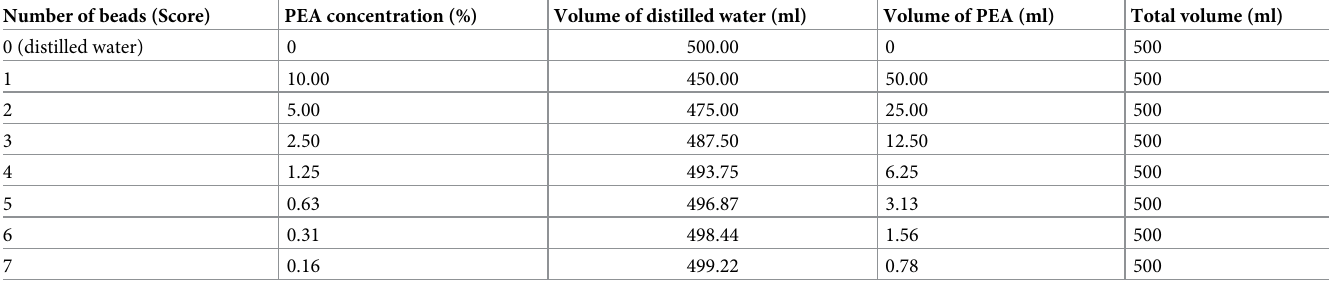
Table 1. Eight types of beads with seven PEA concentrations and volume of distilled water. Number of beads (Score) PEA concentration